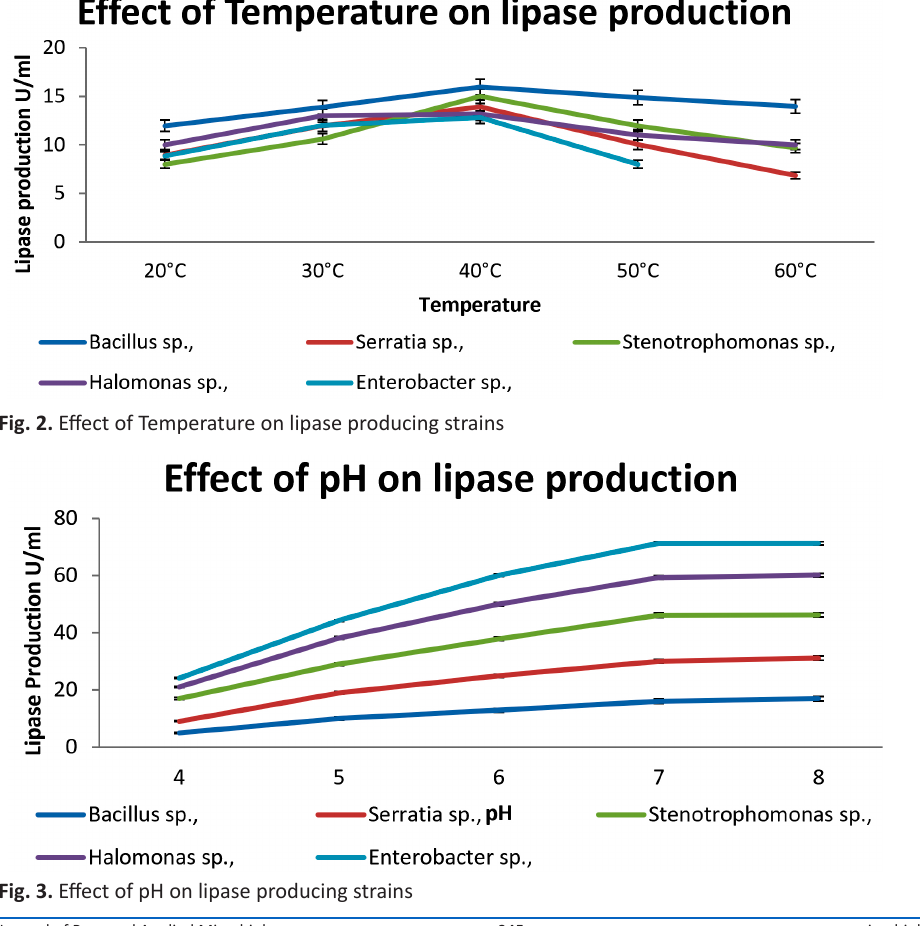
Fig. 3. Effect of pH on lipase producing